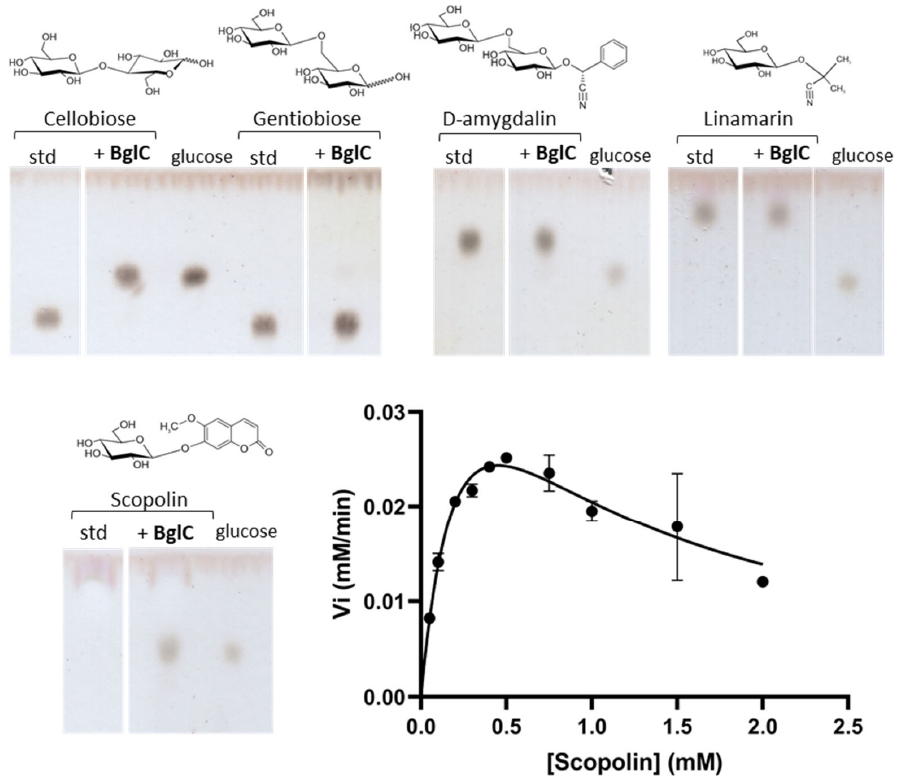
Figure 2. Beta-glucosidase activity of BglC on scopolin. Upper and bottom left panels: TLC plates revealing the release of glucose after incubation of a variety of substrates (5 mM) with His 6 -BglC (1 μ M) compared to the intact substrate (standard (std)). The respective chemical structures of the substrates are displayed above each name. Note that scopolin and its aglycone scopoletin both migrate almost at the same height as the solvent front, which makes it difficult to visualize these compounds. Bottom right panel: Plot of the initial velocity (V i , mM/min) estimated by the rate of glucose released by His 6 ‐ BglC as a function of scopolin concentrations (in mM). Individual values were entered into the GraphPad Prism software (9.2.0), which fitted the data to the Substrate Inhibition model. Error bars display the standard deviation values determined for the V i for three replicates at each substrate concentration.